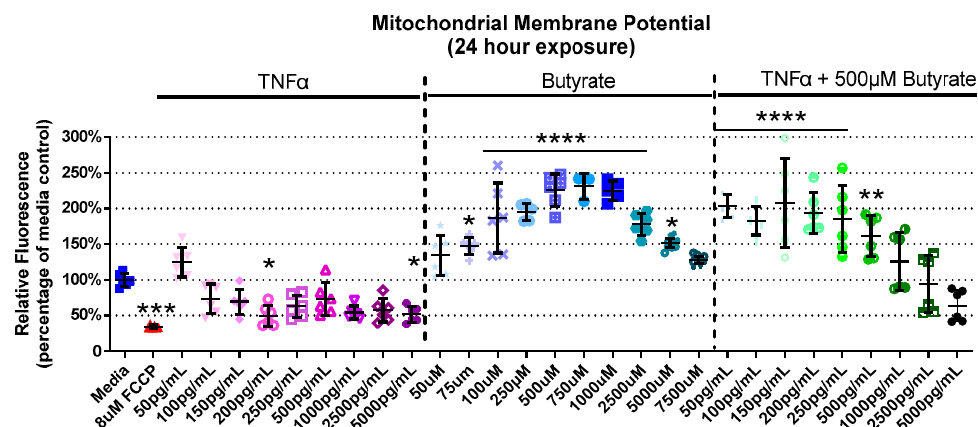
Figure 3. Mitochondrial membrane potential after exposure to butyrate and TNF α at 24 h. FCCP was used as positive control. Relative red/green fluorescence ratio is graphed for each experimental group and is normalized to the medium control (mean relative fluorescence ± standard deviation). Asterisks indicate degree of significance from medium control (Kruskal–Wallis test followed by a Dunn’s multiple comparison test relative to the medium control, n = 3/experiment; significance determined at *= p < 0.05, ** = p < 0.01, *** = p < 0.001, ****= p < 0.0001). Note: for statistical comparisons made amongst all groups, see Supplemental Data Table S3.